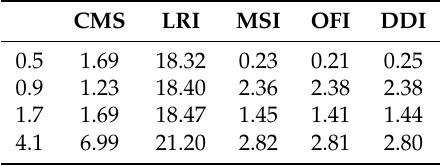
Table A7. Accel.WR in large